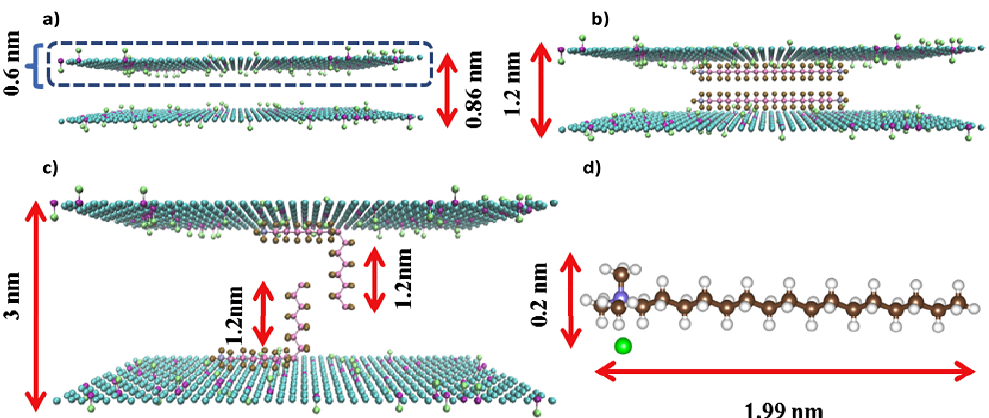
Figure 6. Schematic illustration of possible arrangement of C16TAB within GO membranes: ( a ) The pure GO membrane; ( b ) Two C16TAB paralleled to GO plane; ( c ) Two C16TAB perpendicularly arranged to GO laminate plane; ( d ) Molecular structure of C16TAB with C1–N chain length about 1.99 nm [96]. Copyright 2017 Elsevier.